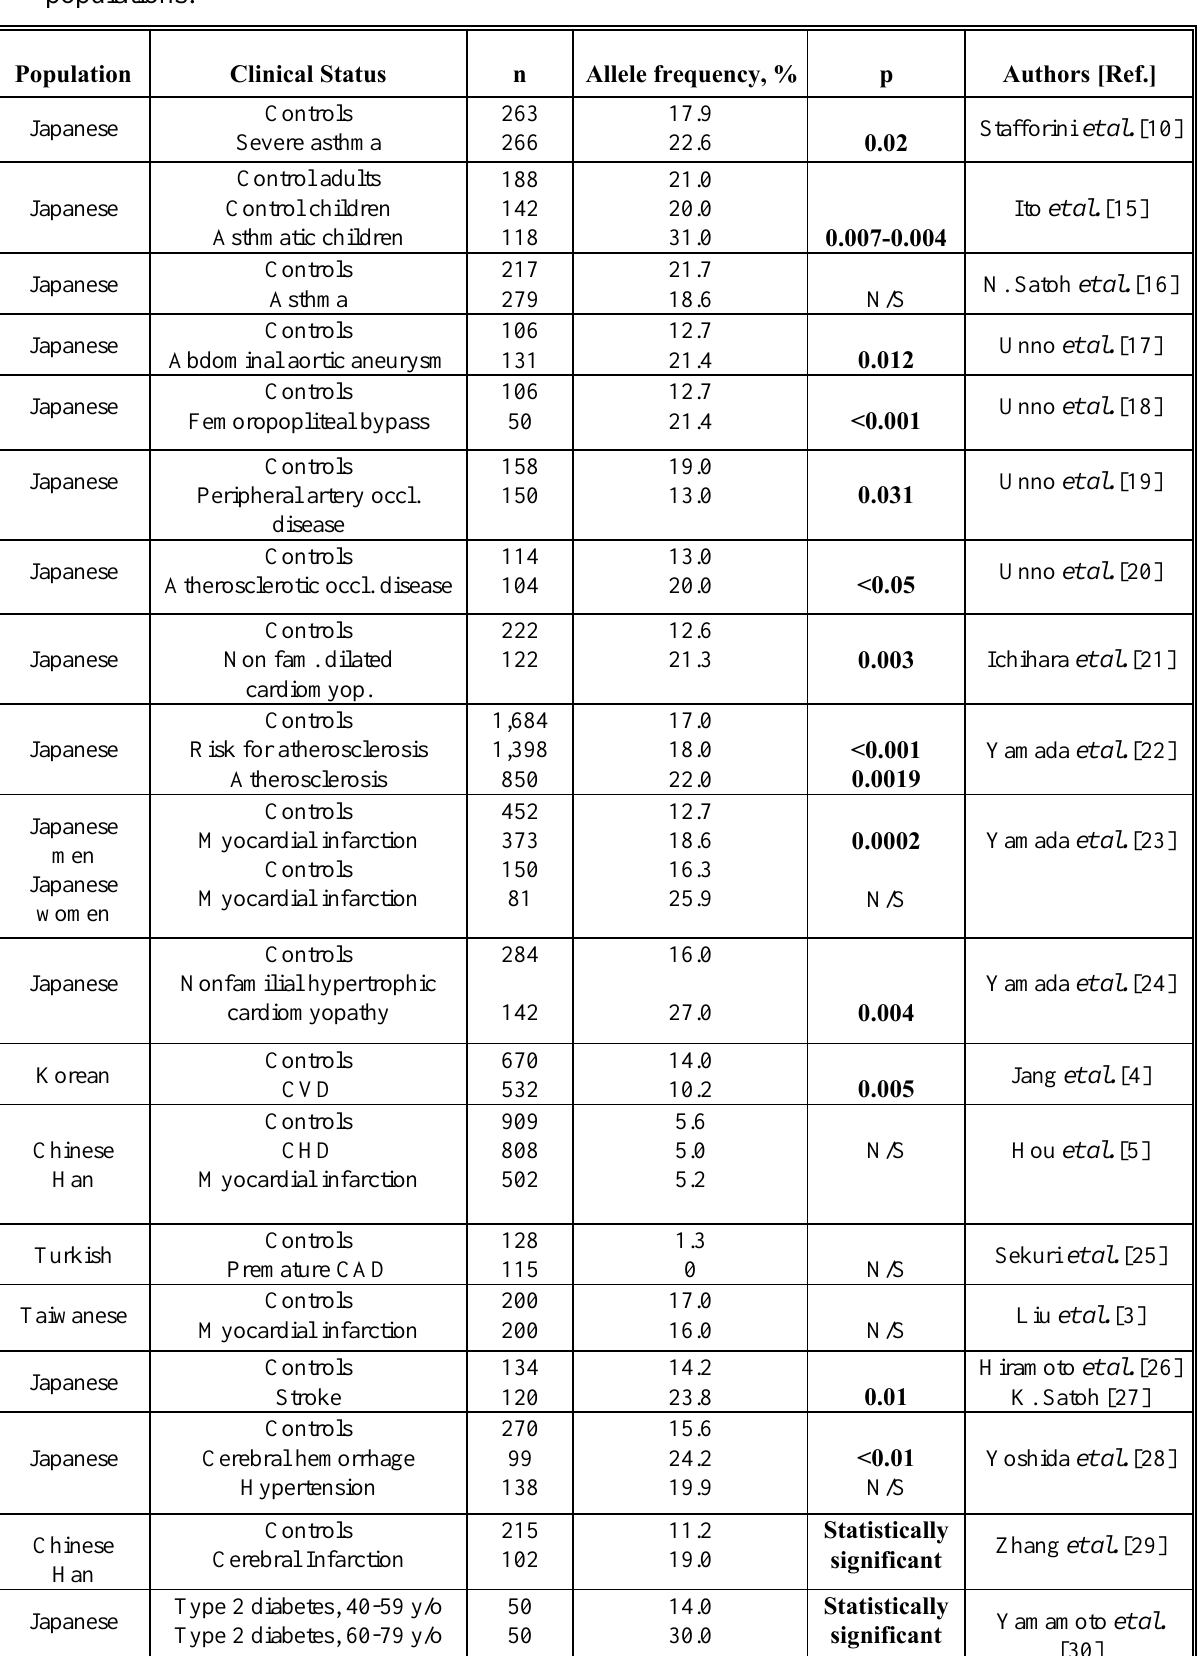
Table 1. The V279F (rs16874954) polymorphism: allele frequency in control and diseased